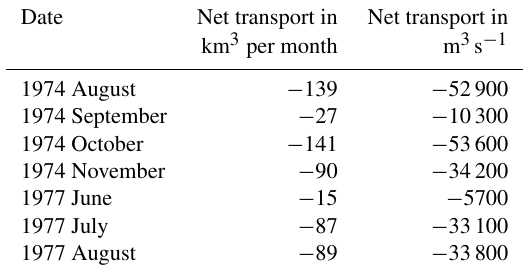
Table 1. Net water transport in the Åland Sea according to Ambjörn and Gidhagen (1979). The last column has been calculated assum- ing 30.437d per